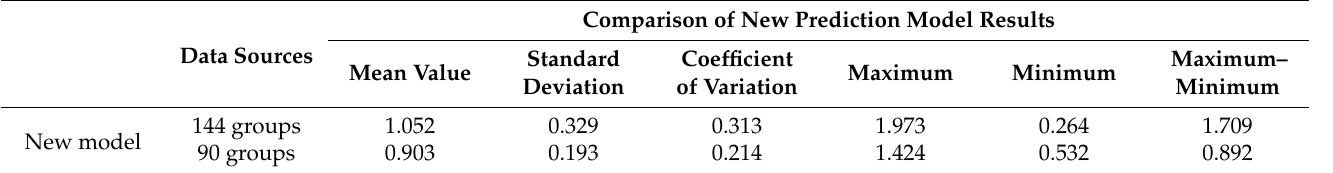
Table 4. Comparison of corrosion rate results of new prediction models based on experimental data.